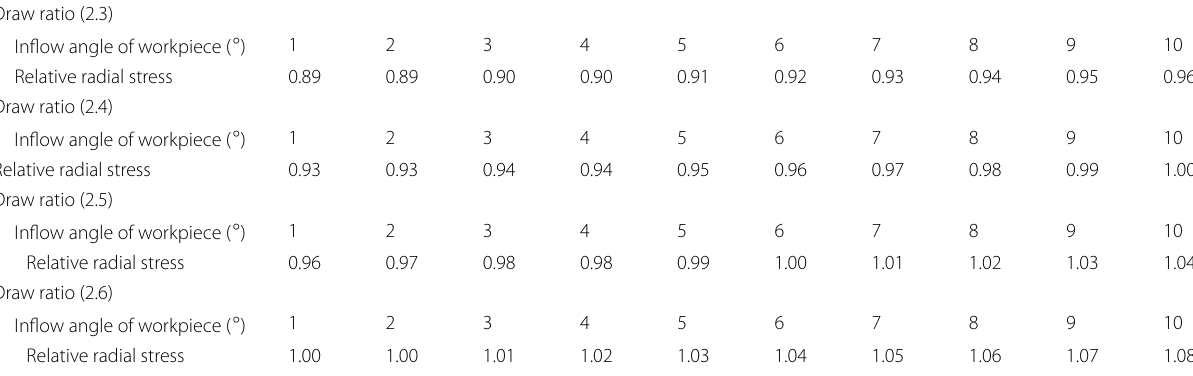
Table 6 Relative radial stress according draw ratios (2.3–2.6) and inflow angles (1 ◦ –10 ◦ ) Draw ratio (2.3)